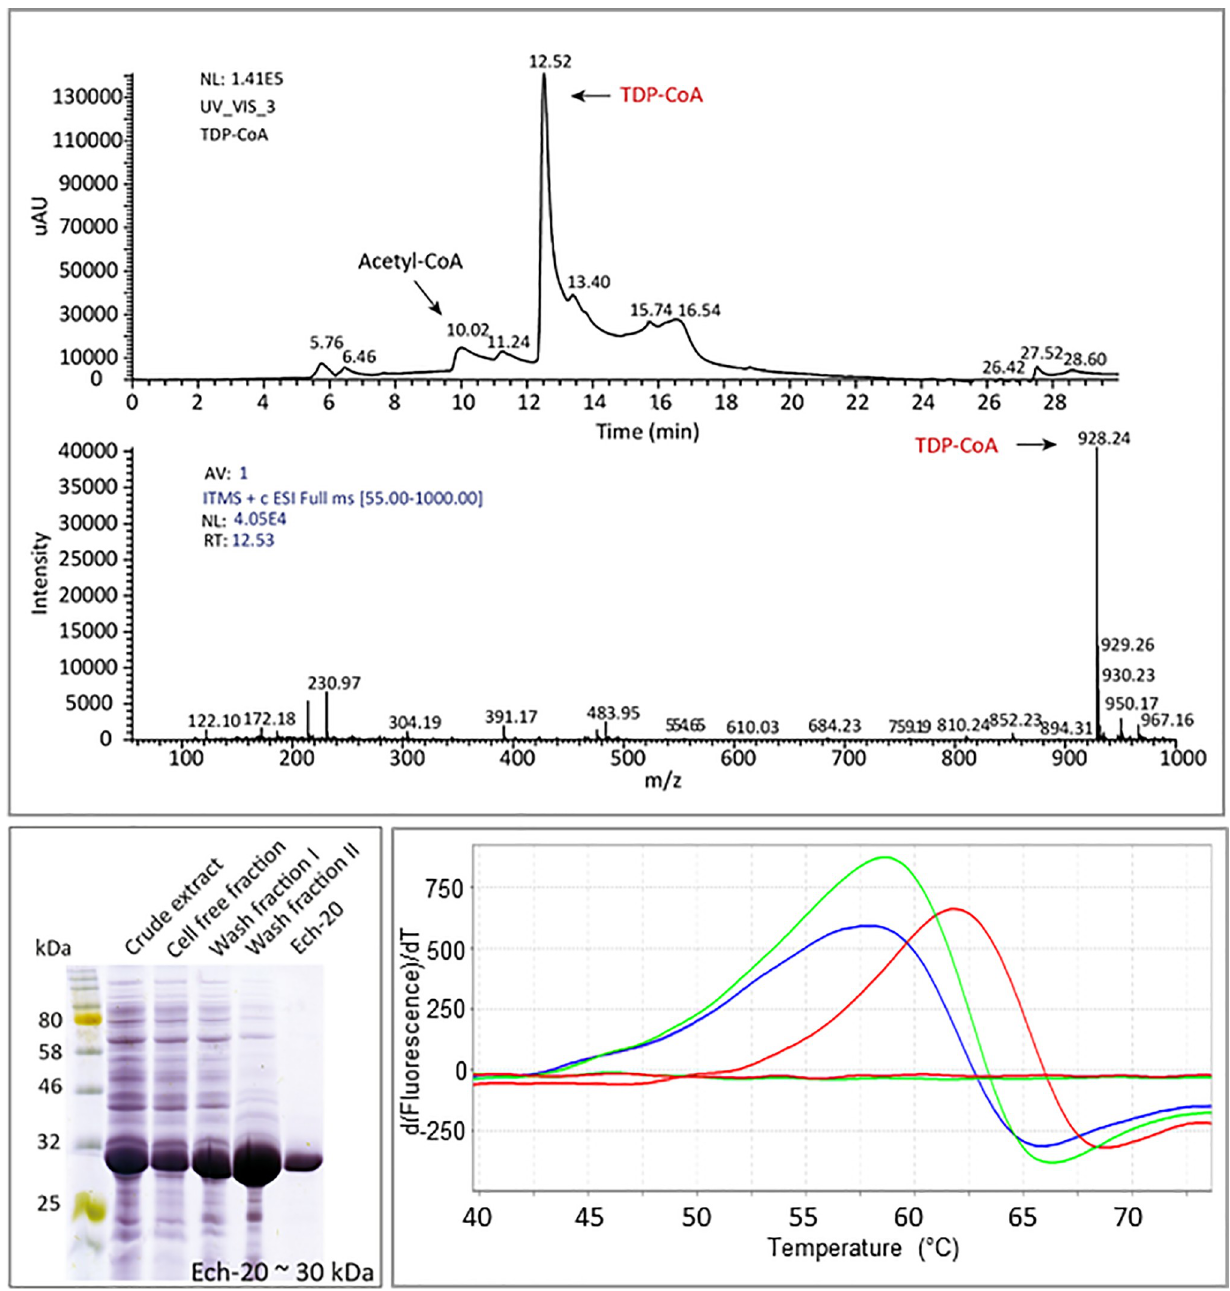
Fig 8. Synthesis of TDP-CoA and application in a thermal shift assay with Ech-20. A) Analysis of TDP-CoA via HPLC/MS using an AcclaimTM 120 C18 column. Detection was done at 259 nm with a photodiode array detector. TDP-CoA was detected at 12.52 min (upper diagram) and analyzed via mass spectrometry with 928.24 m/z (lower diagram). B) Heterologous production of Ech-20 in E . coli Bl21 (DE3) pLysS pET-32a(+):: ech-20 . Purification of Ech- 20 was performed via IMAC. 40 μ g of protein were loaded onto the gel, except for elution samples of which only 5 μ g were applied to the gel. C) Shift in the melting temperature of Ech-20 (2 μ M) in presence of 2 mM TDP-CoA (red) and 2 mM TDP (green) shown in a thermal shift assay. The assay was performed with 2 μ M protein in presence of 2 mM TDP-CoA in 100 mM Tris/HCl (pH 8). Control without protein (lines without peaks; green (TDP) and red (TDP-CoA)), control without ligand